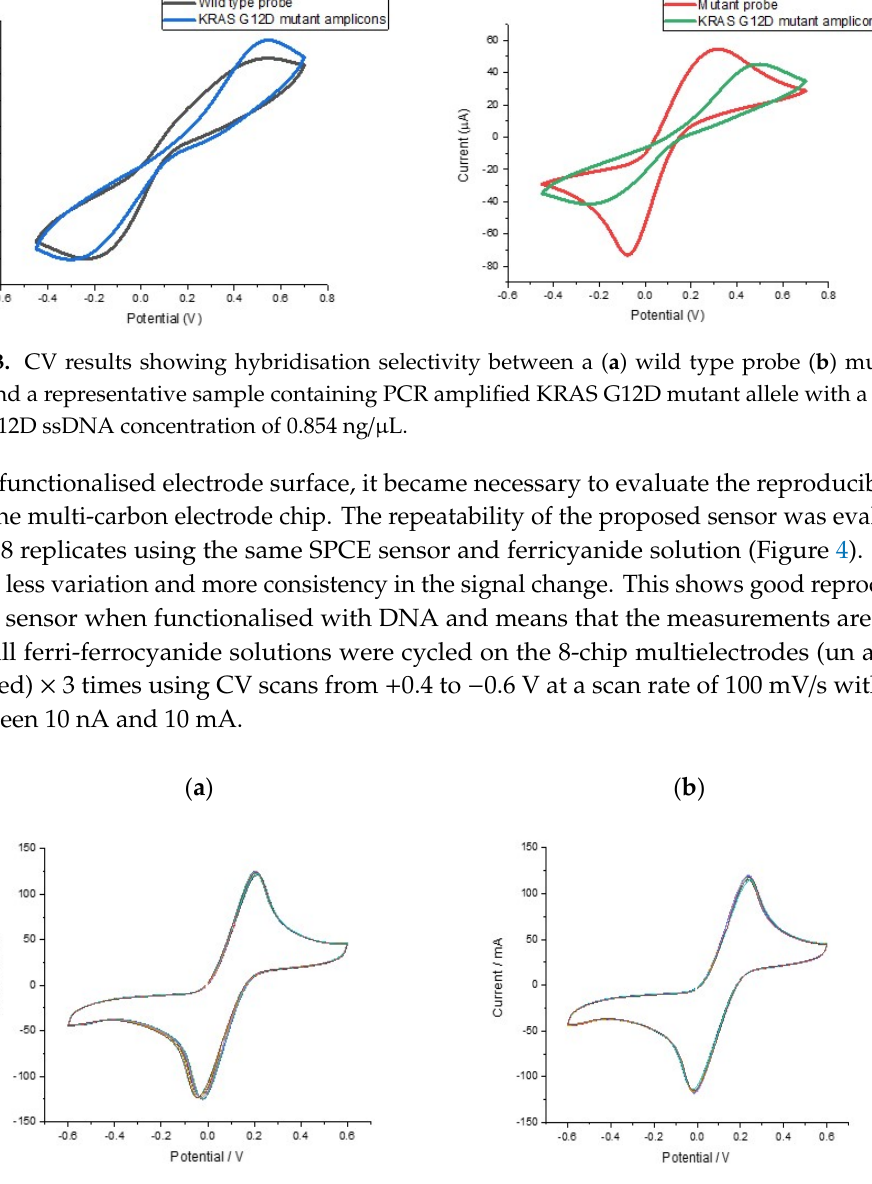
Figure 4. CV results showing repeated cycling of ( a ) KRAS G12D probe functionalised electrodes ( b ) KRAS G12D amplicons over 8-chip multielectrodes using the same current and voltage inputs .